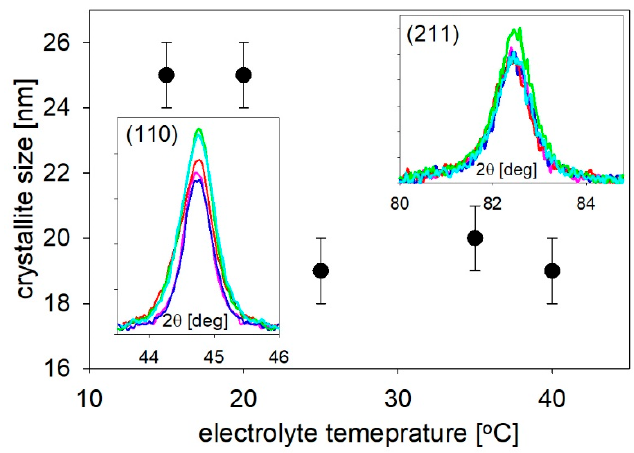
Figure 10. The mean value of crystallite size was calculated according to Scherer’s formula based on the (110) and (211) peaks. The color of the lines corresponds to the description presented in Figures 2 and 3.